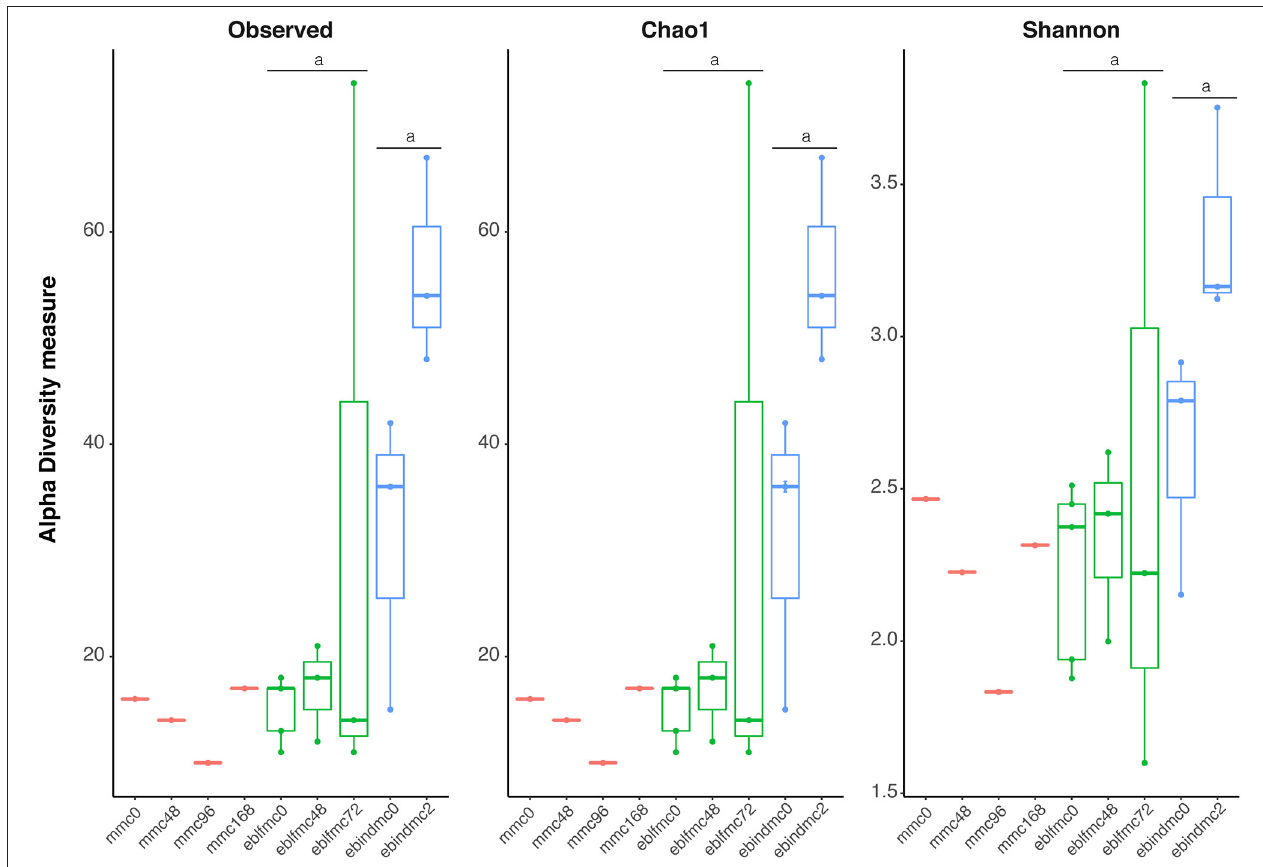
FIGURE 1 | Bacterial richness and diversity indices (16S rRNA gene) obtained from the massive sequencing analysis of the different types of bread doughs (MMC, sourdough; eblfmc, Elias–Boulanger long-fermentation raw dough; ebindmc, Elias–Boulanger industrial raw dough) at different times of fermentation. Statistical comparisons between eblfmc and ebindmc groups are indicated by superscript letters: same letters indicate statistically significant differences ( p < 0.05).